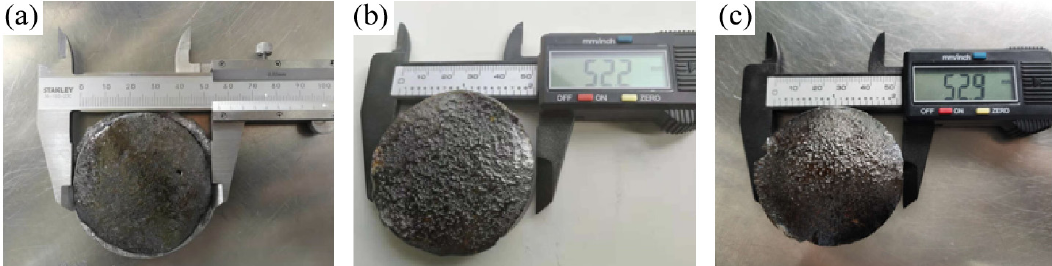
Figure 7. Crystal morphology. ( a ) Sample 1; ( b ) Sample 2; ( c ) Sample 3